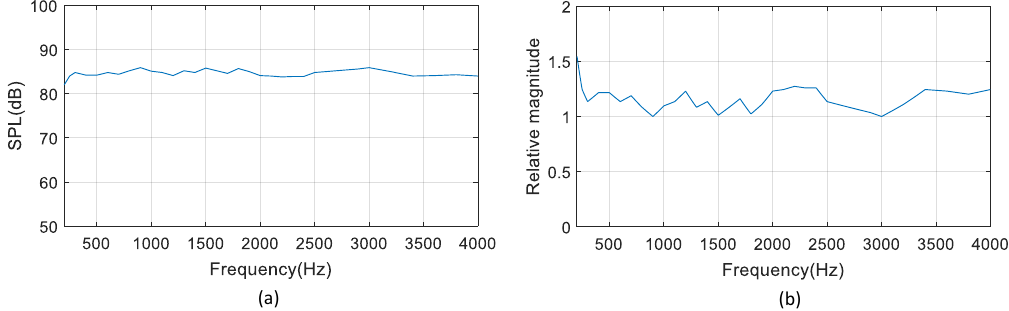
Figure 5. ( a ) The magnitude response curve. ( b ) The compensation magnitude